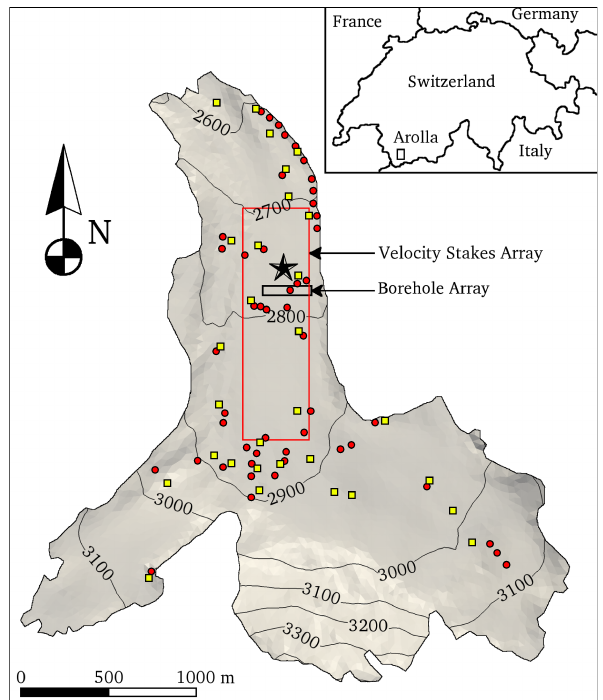
Fig. 4. Map of Haut Glacier d’Arolla with the position of the bore- hole and velocity stakes arrays. The star is the position of the refer- ence point used in Sect. 5. The glacier surface elevation is contoured every 100m. Red circles are the position of the moulins used for the dye-tracing experiments in 1989 and 1990; the yellow squares are the position of the moulins recorded in 1993 and used for the mod-